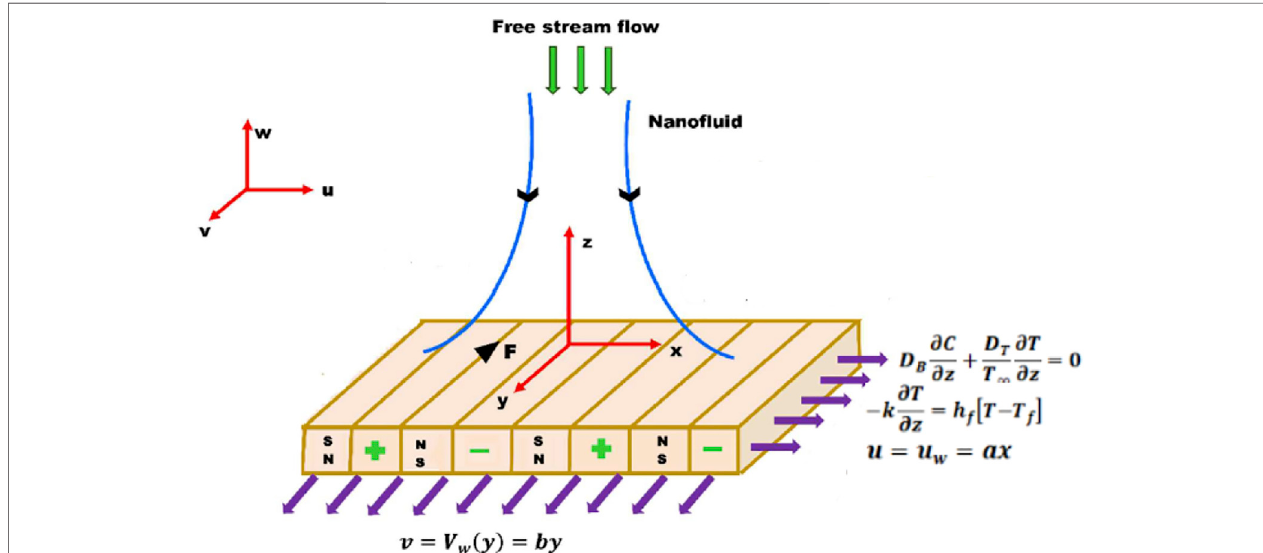
FIGURE 1 | Physical model of the given